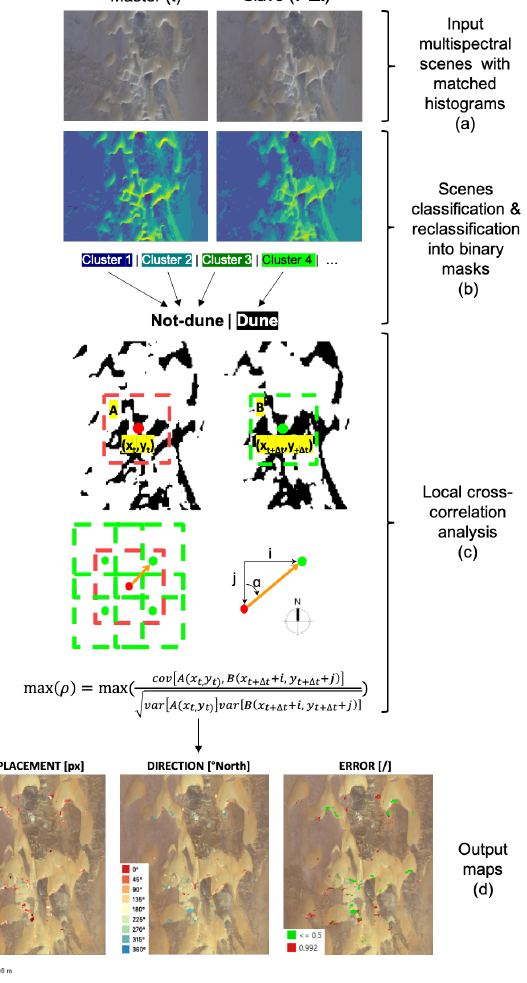
Figure 2. Schematic of the proposed workflow for the desert dunes movement analysis using multispectral